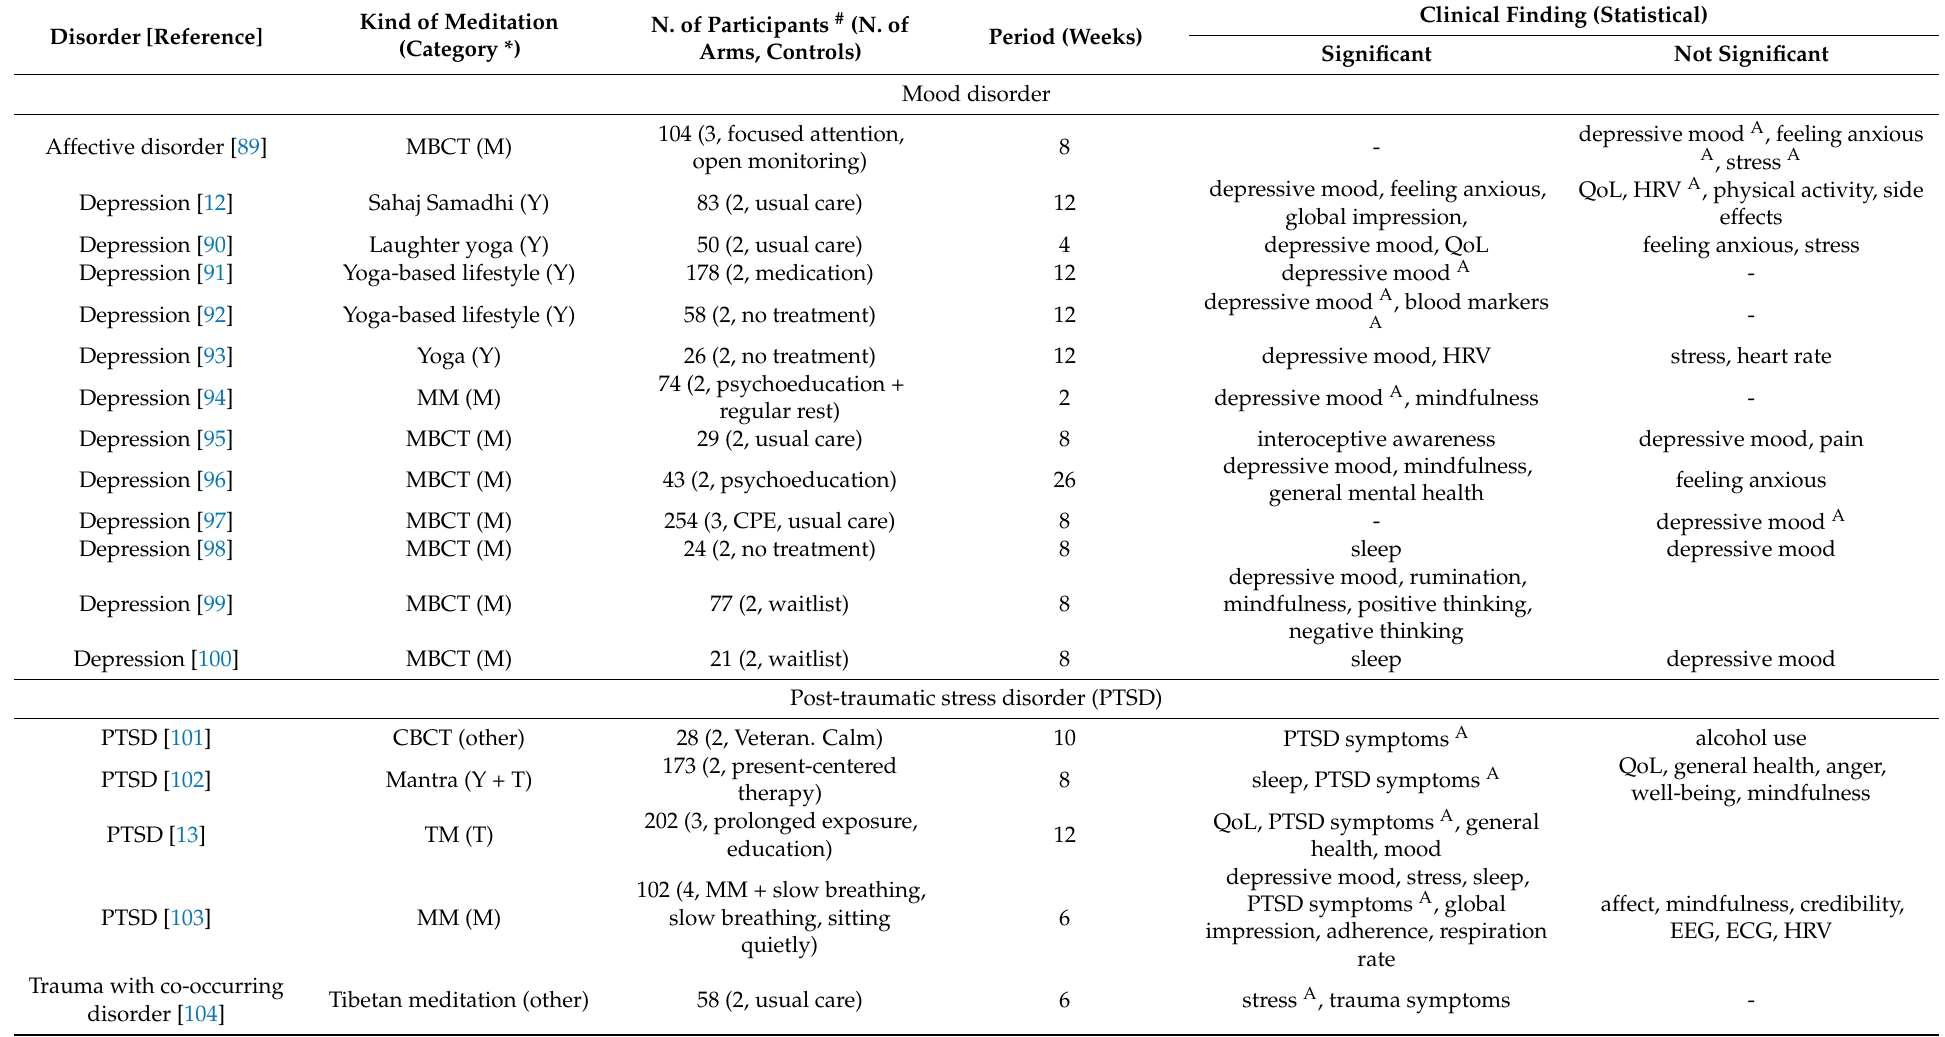
Table 3. Summary of the RCTs for participants with mental